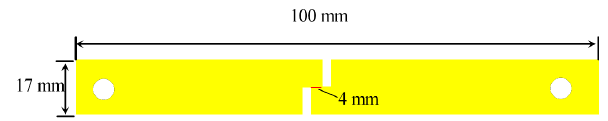
Figure 4: Geometric size of the experiment specimen